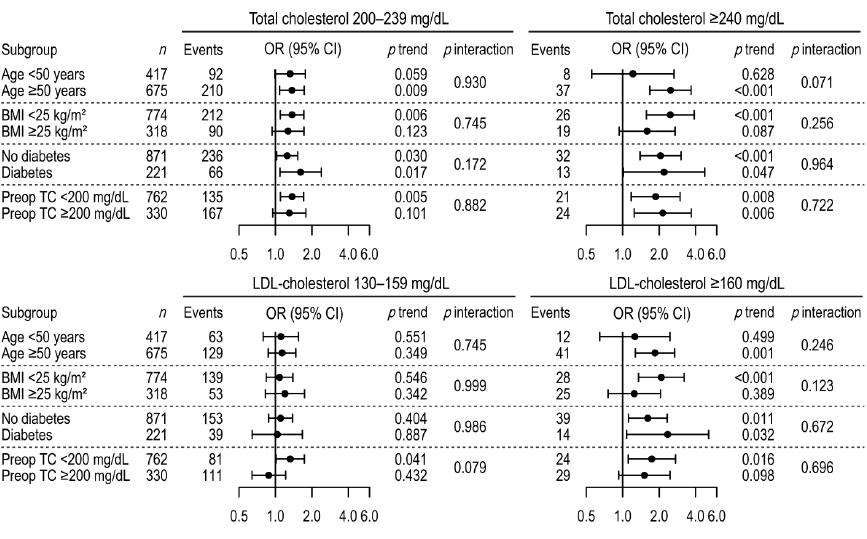
Figure 3. Association between follow-up TSH group and hypercholesterolemia in subgroup analysis. Multinomial multivariable logistic regressions were adjusted for age at follow-up, follow-up period, cigarette smoking status, body mass index, systolic blood pressure, fasting glucose level, and preoperative cholesterol level. CI, confidence interval; OR, odds ratio; LDL, low-density lipoprotein; TSH, thyroid-stimulating hormone.